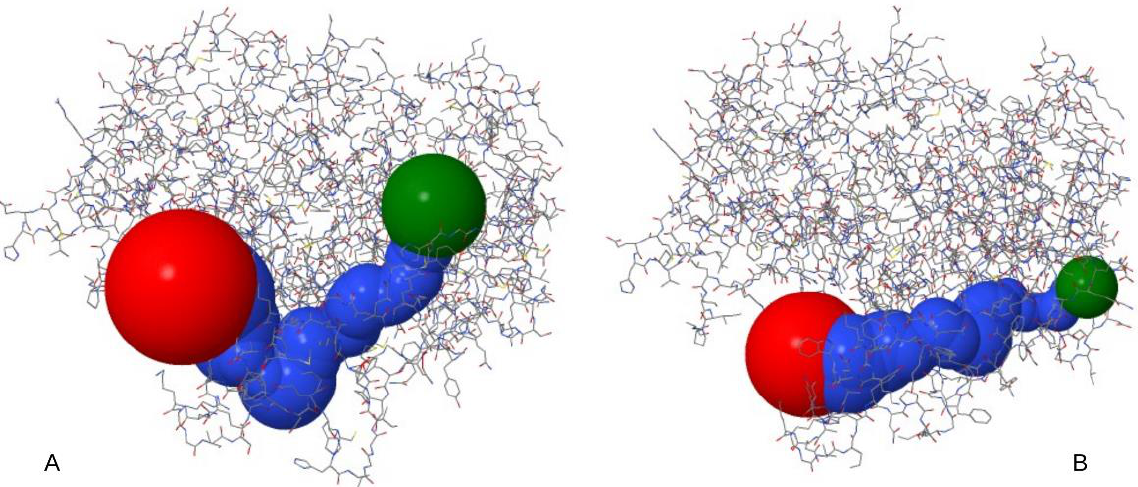
Figure 1. An example of the visualization of a predicted molecular tunnel in methyl-coenzyme M reductase (alpha subunit) from Methanomicrobium mobile (( A ); 37 °C optimum growth temperature) and Methanopyrus sp. KOL6 (( B ); 110 °C optimum growth temperature). Molecular tunnel length, surface, and volume estimates for the major subunits of the Mmr and Hdr proteins were plotted against the optimum growth temperature for methanogenic Archaea covering a wide range of temperatures (Figures 2 and 3). The numbers of Mmr sequences analyzed were 179, 183, and 166 from the alpha, beta, and gamma subunits, respectively. The total of sequences processed for the Hdr sequences was: 52, 159 and 107 from the A, B and C subunits, respectively. It is worth noting that different subunit genes can present completely different tunnel/channel dimensions because their amino-acid sequences and structures are different, and this also depends on the specific function of each